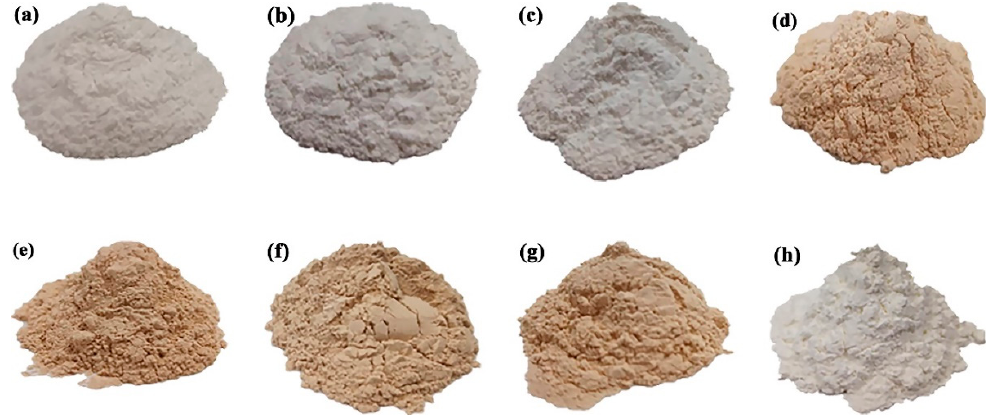
Figure 5. Macroscopic morphologies of granulated powders calcined for 2 h at different temperatures: ( a ) RT; ( b ) 900 °C; ( c ) 1000 °C; ( d ) 1100 °C; ( e ) 1200°C; ( f ) 1300 °C; ( g ) 1400 °C; ( h ) 1500 °C.